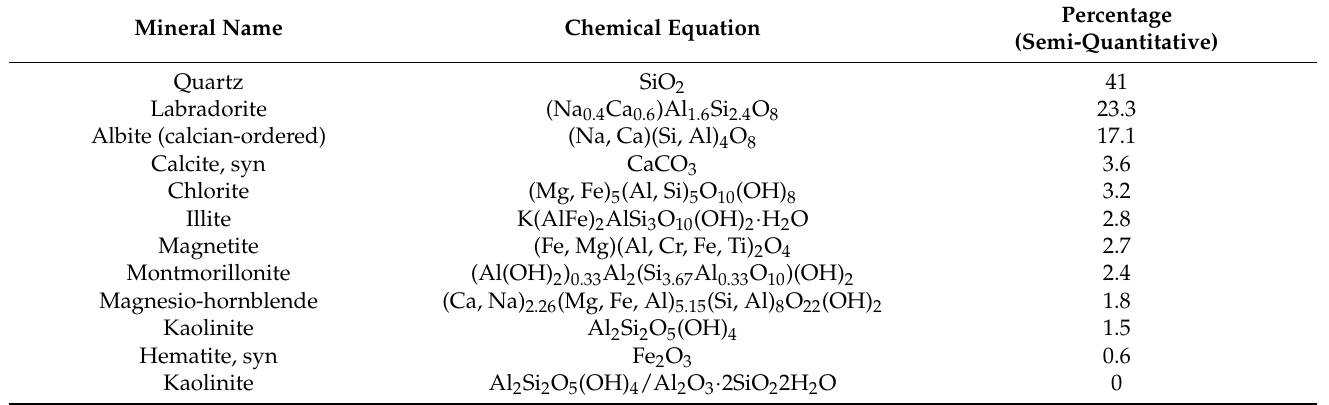
Table 3. Characteristics of the soil samples of the area (properties and XRD